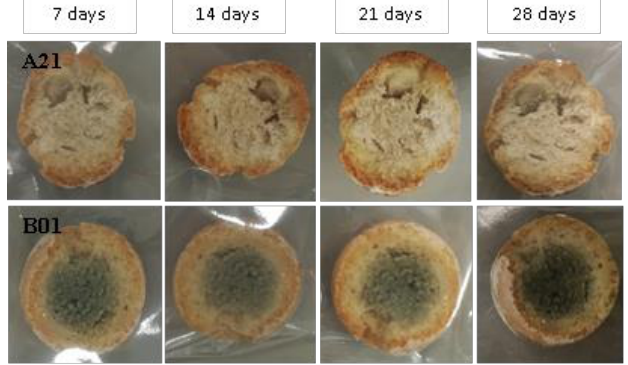
Figure 15. Examples of bread made from sourdoughs inoculated with the combination of isolates C1, C6, and C9, then artificially contaminated with Penicillium expansum and incubated at room temperature for 7, 14, 21, and 28 days.